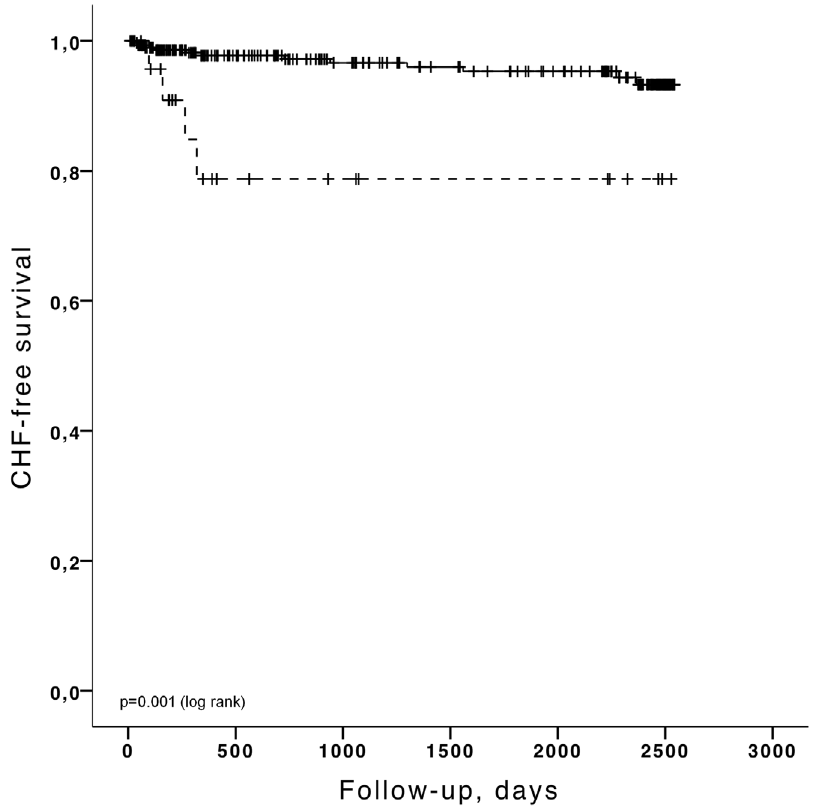
Figure 3. Kaplan-Meier analysis for the probability of CHF hospitalization-free survival according to BNP levels below (black, solid) or above the cut-off level of 100 pg/ml (black, dashed). tration of BNP . 100 pg/ml had a higher risk of developing CHF (figure 3) (log rank p , 0.001) and BNP . 100 pg/ml was also predictive of overall death (figure 5) (log rank p =0.003). LVEF ,